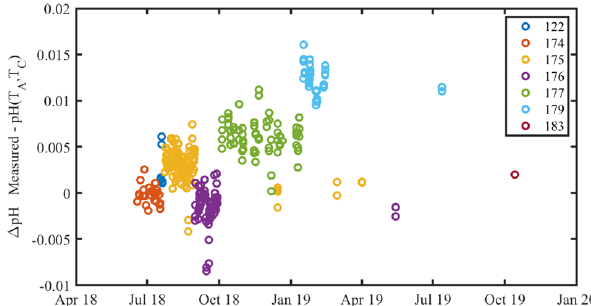
Figure A1. A time series of the residual between measured and cal- culated CRM pH throughout the experiment. Marker color denotes CRM batch number. There is a clear variability between measured and calculated pH, which is typical of CRM batches (Andrew Dick- son, personal communication, 2019). There was no observable sys- tematic drift in the pH system during the experiment. The mean standard deviation of pH measurements within a CRM batch is 0.0016, which is comparable to the 0.0019 reported in Bockmon and Dickson (2015). The same 760nm absorbance wavelength out- lier removal procedure used for tris measurements was applied to CRM